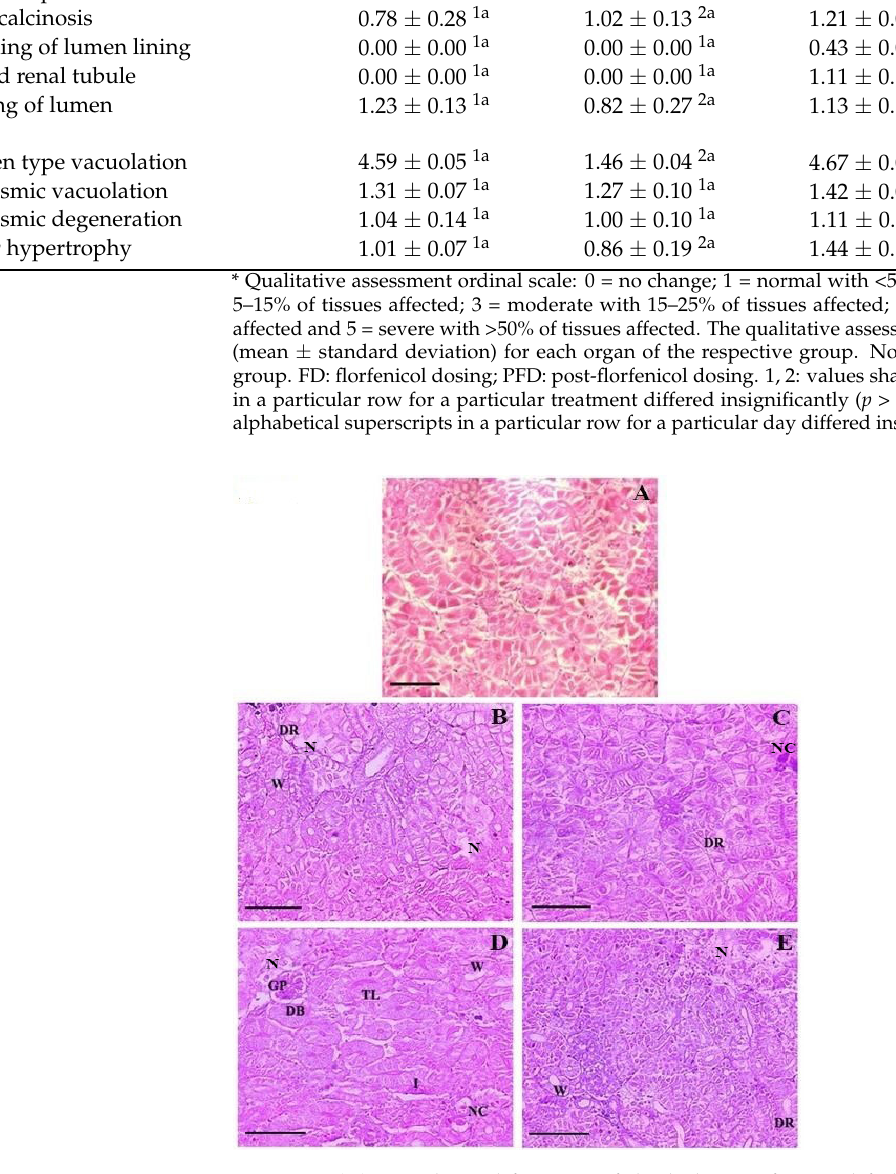
Figure 5. ( A ) Histological features of the kidneys of control-fed Oreochromis niloticus juveniles showing normal tissue architecture, ×200 H&E staining. Histopathological changes in the kidneys of florfenicol (FFC)-dosed O. niloticus juveniles at 15 mg kg biomass − 1 day − 1 (1× group) for 10 con- secutive days ( B ) on day 10 FFC-dosing showing degeneration of the renal tubular epithelium (DR), necrotized renal tubules (N), and widened lumen (W), ×200 H&E staining; and ( C ) on day 21 post-FFC-dosing showing degeneration of the renal tubular epithelium (DR) and nephrocalcinosis (NC), ×200 H&E staining. Histopathological changes in the kidneys of FFC-dosed O. niloticus ju- veniles at 45 mg kg biomass − 1 day − 1 (3× group) for 10 consecutive days ( D ) on day 10 of FFC dosing showing glomerulopathy (GP), dilated Bowman’s space (DB), necrotized renal tubule (N), thick- ening of the lumen lining (TL), widened lumen (W), inflamed renal tubule (I). and nephrocalcinosis (NC), ×200 H&E staining; and ( E ) on day 21 post-FFC-dosing showing degeneration of the renal tubular epithelium (DR), necrotized renal tubule (N) and widened lumen (W), ×200 H&E staining. The liver sections of the 10-day FFC-dosed groups lost their characteristic liver ar- chitecture with markedly increased glycogen-type vacuolation in hepatocytes (Figure 6A–E). Severe glycogen-type vacuolation was noted on day 10 FD in the 1× (Figure 6B) and 3× (Figure 6D) groups, respectively. Moreover, mild cytoplasmic vacuolation, cyto- plasmic degeneration, and cellular hypertrophy were noted in both groups. Eosinophilic bodies were also documented in the 1× group on day 10 FD. On day 21 FD, the intensity of damage was reduced but the persistence of cytoplasmic vacuolation in the 1× (Figure 6C), as well as considerable cytoplasmic vacuolation and cellular hypertrophy, was ob- served in the 3× groups (Figure 6E). Moderate persistence of glycogen-type vacuolation was noted in the 3× group on day 21 PFD.